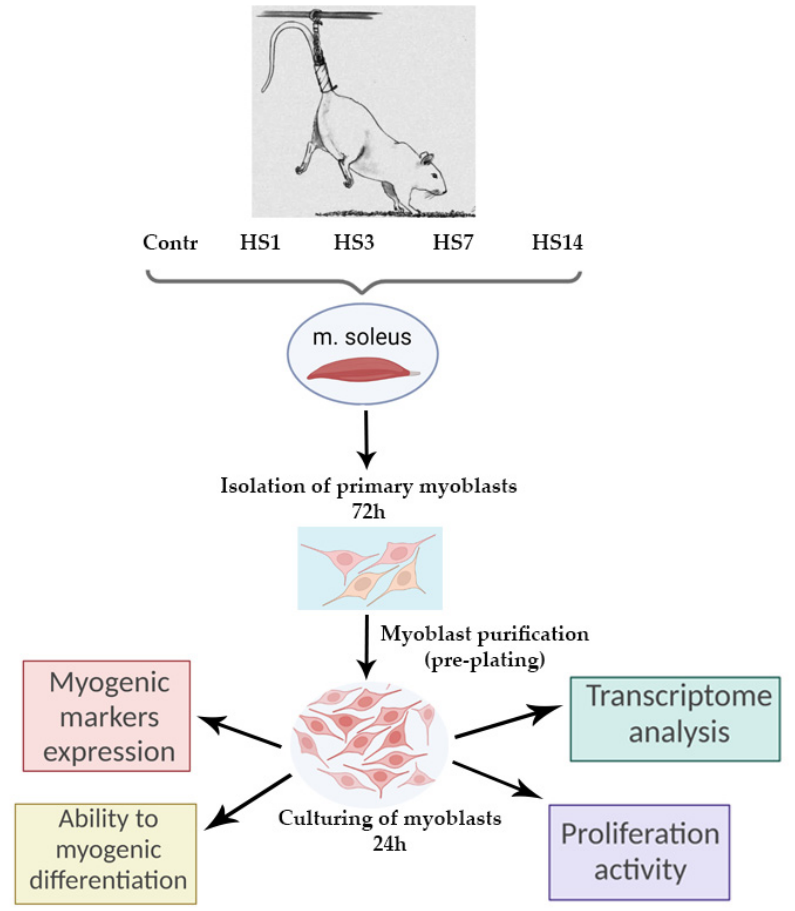
Figure 7. The experimental design.